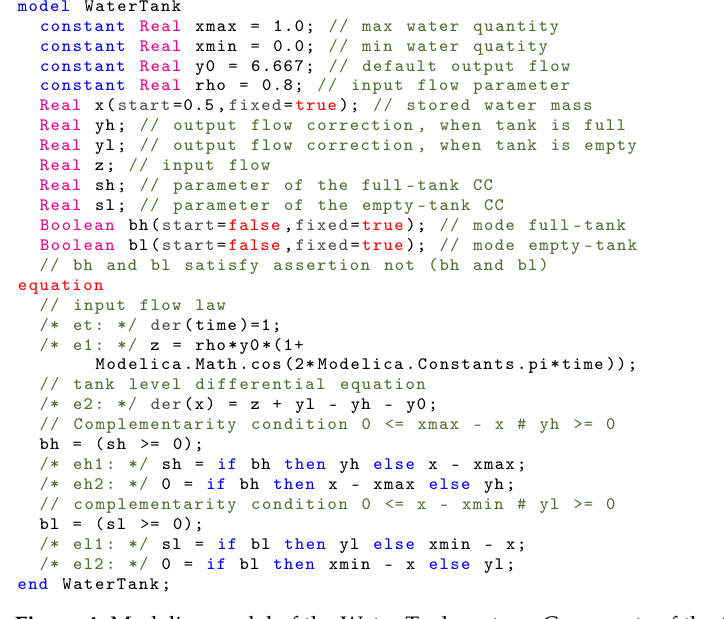
Figure 4. Modelica model of the Water Tank system. Comments of the form /* id: */ define the equation labels that appear in the dependency graphs in Figures 6 and 7.